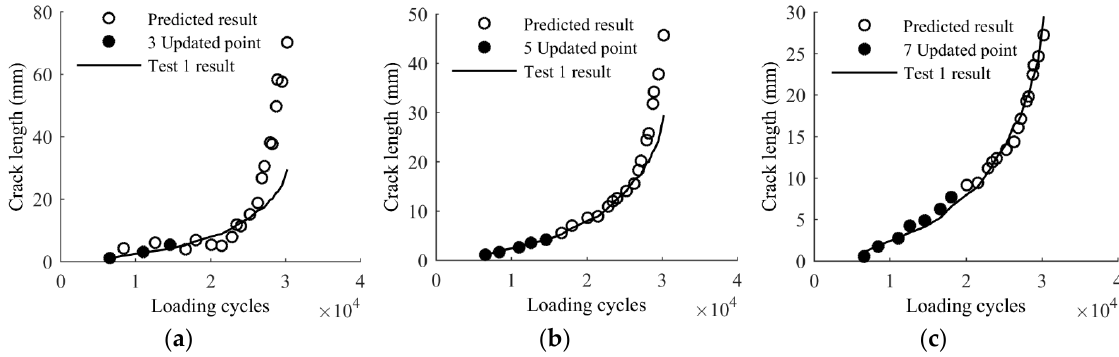
Figure 11. Updated model predictions of crack growth of Test 1: ( a ) updated with three points; ( b ) updated with five points; and ( c ) updated with seven points.